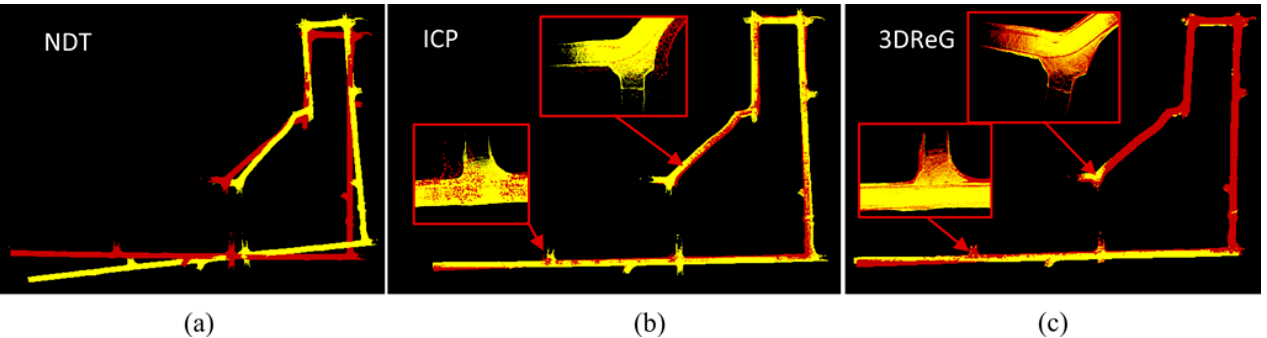
Figure 9. ( a ) Point cloud coregistered using NDT algorithm. An inaccurate alignment of two point clouds can be observed. ( b ) Point clouds coregistered using the ICP algorithm. Mismatching can be seen at some cross-cuts in the mine section. ( c ) Point cloud coregistered using 3DReG where 3DUID is used for initial alignment followed by a fine refinement of the point cloud using ICP. A perfect overlap between two point clouds is visible. Table 2. A cloud-to-cloud distance comparison between coregistered and georeferenced point clouds. Georeferencing and Coregistration Method Median C2C Distance (in m) Time Iterations Sampling Georeferencing Using Surveyed 3DUID